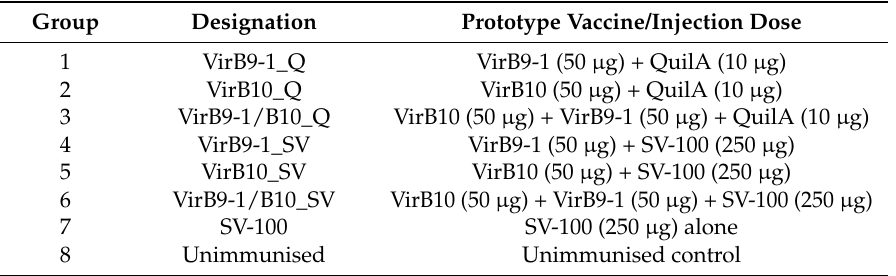
Table 1. Immunisation groups in mice trial. All doses were administered at the tail base.